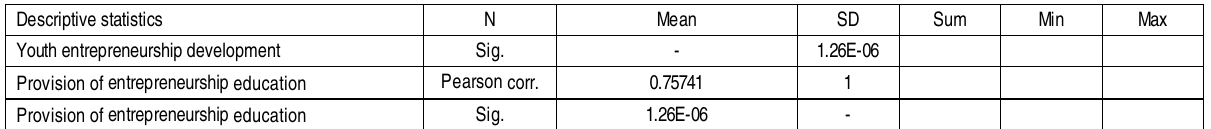
Table 2 (cont.). Correlation between the provision of entrepreneurship education & training and youth entrepreneurship development